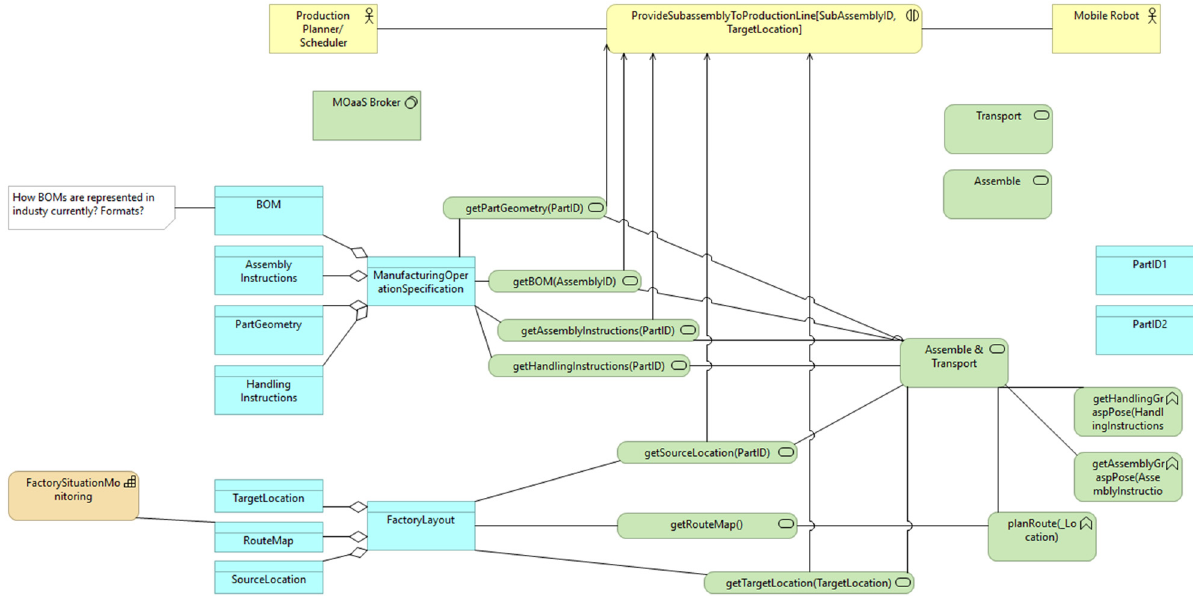
Figure 6: Service model with data: Manufacturing operation speci fi cation compared to MBOM and